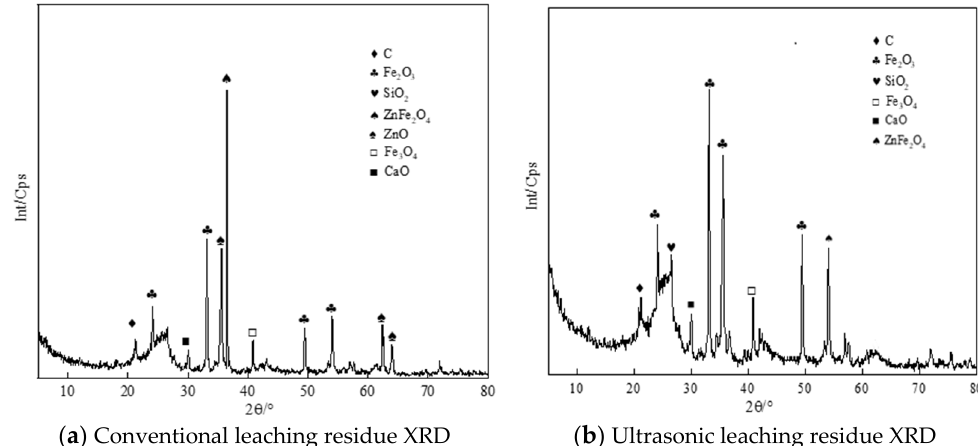
Figure 14. XRD pattern of leaching residue ( a ) conventional: temperature = 60 ℃ , liquid ‐ solid ratio = 12:1, stirring speed = 400 rpm, time = 480 min; ( b ) ultrasonic: leaching temperature = 60 ℃ , liquid ‐ solid ratio = 12:1, ultrasonic power = 450 W, time = 240 min.